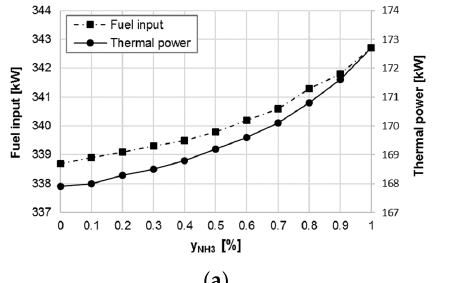
Figure 6. Effects of increasing ammonia blending ratio (y NH3 ) on: ( a ) mass flow rate of air, fuel, and flue gas; ( b ) compressor pressure ratio and turbine expansion ratio.